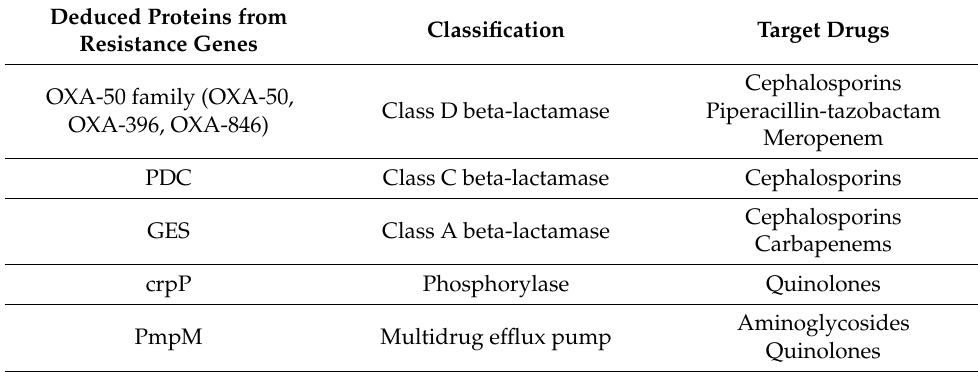
Table 5. Target drugs and the mechanism of action of the proteins, deduced from the main resistance genes